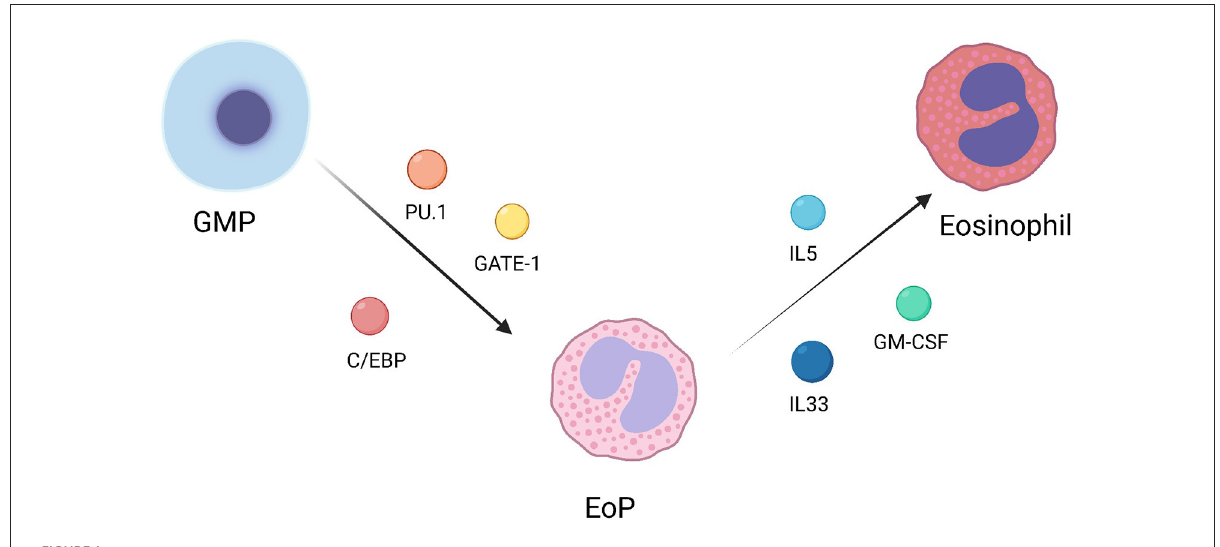
FIGURE1 Differentiation of mature